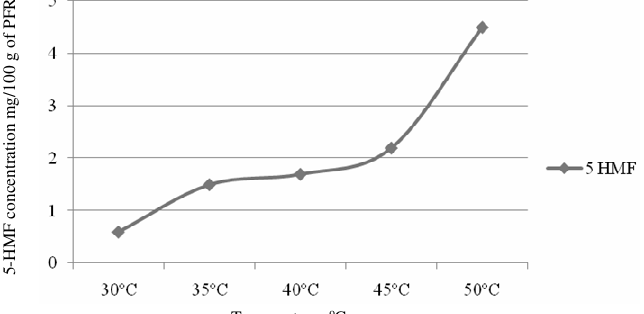
Figure 1. Monosaccharide yield after pretreatment with diluted NaOH hydrolysis at 35 °C